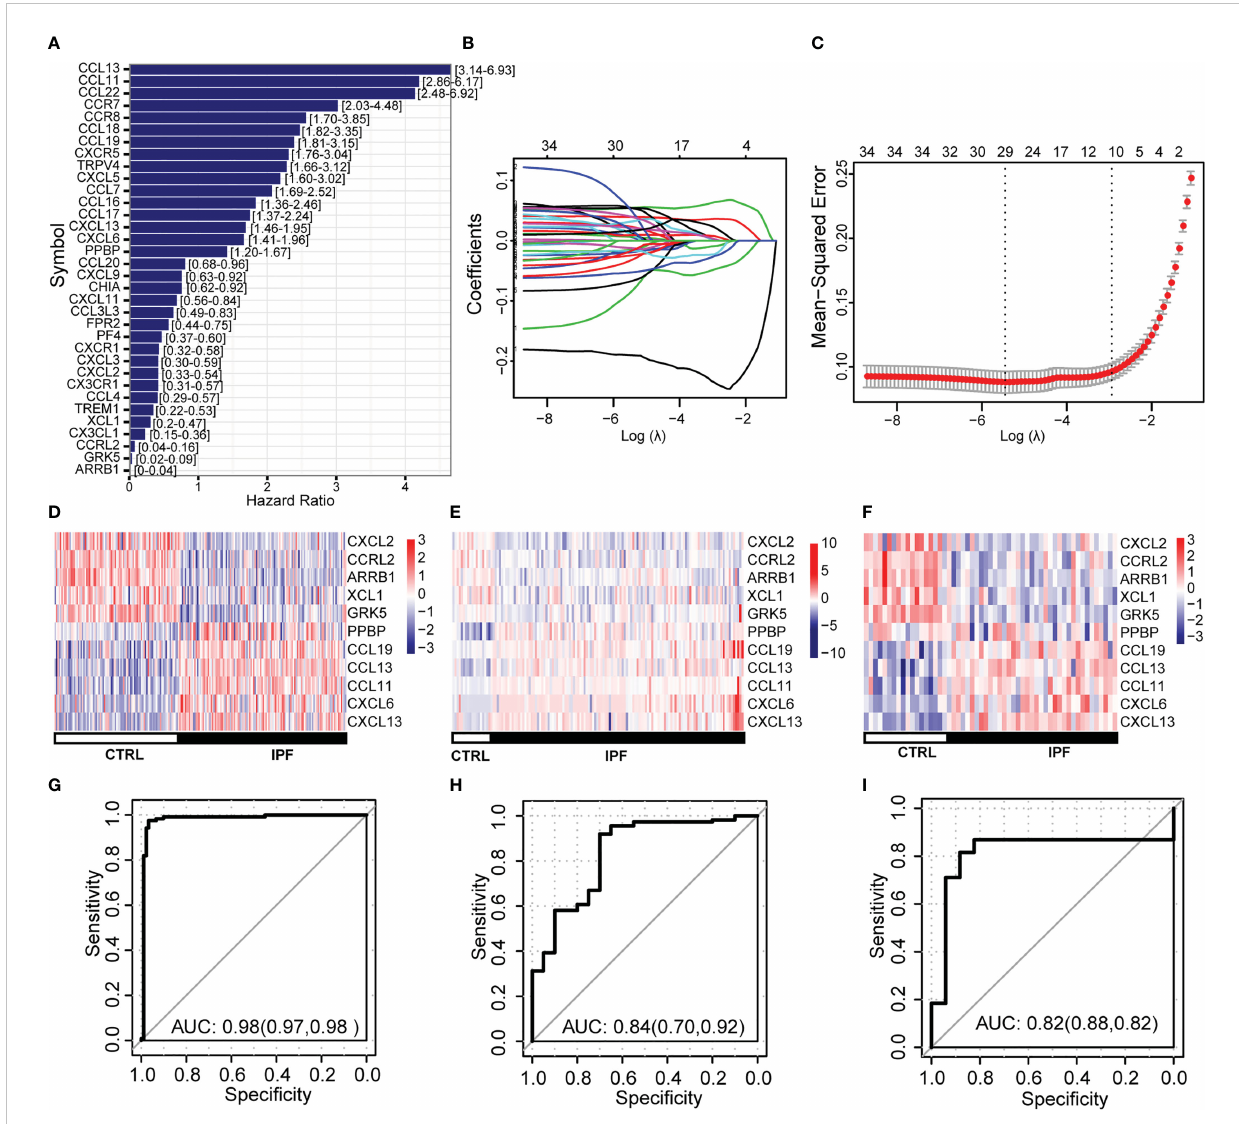
FIGURE 3 Construction and validation of diagnostic models based on CR-DEGs. (A) The logistic regression analysis of CR-DEGs. (B) Diagnostic model construction using a least absolute shrinkage and selection operator (LASSO) Cox regression model. (C) Coef fi cient distribution plots to select the optimum lambda value. (D – F) Heatmap of the gene-expression pro fi les of model-related CR-DEGs in the training (D) and external validation cohorts (E, F) . (G – I) ROC curves of diagnostic models in training (G) and external validation cohorts (H, I)